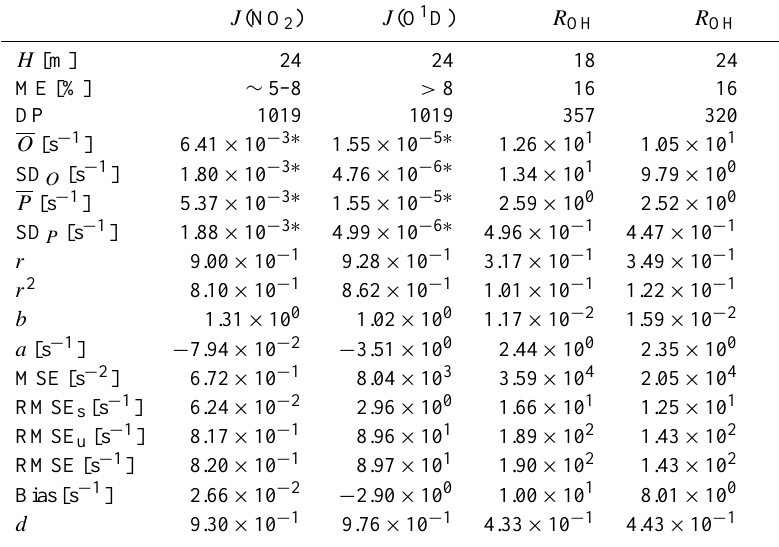
Table 2. Measurement uncertainty and estimates for quality of fit for photolysis rates ( J (NO 2 ) and J (O 1 D)) and the reactivity of OH ( R OH ). ME is reported measurement uncertainty, O and P the measured ( O ) and modelled ( P ) means, SD O and SD P the corresponding SDs and the bias the difference between the mean measured and mean modelled parameter. For the meaning of the remaining symbols, we refer to the description in the Table